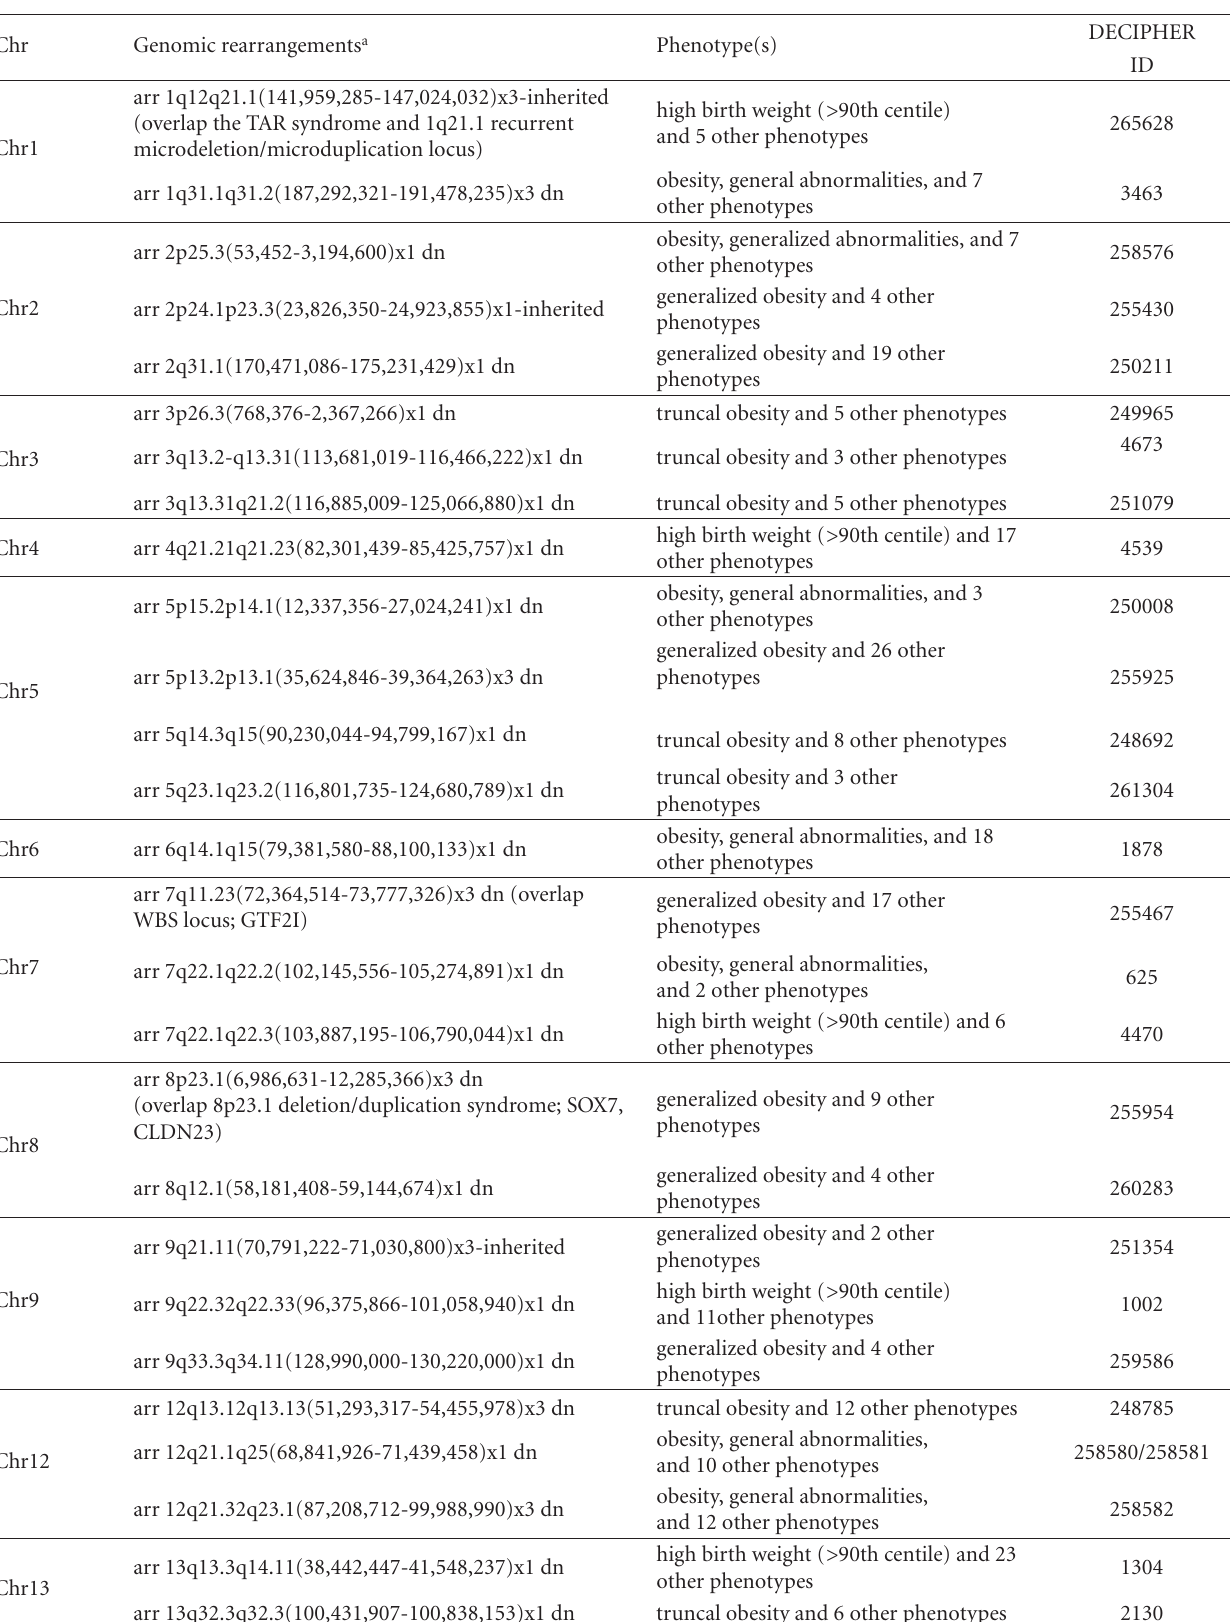
Table 2: CNVs in the DECIPHER database likely to play a role in